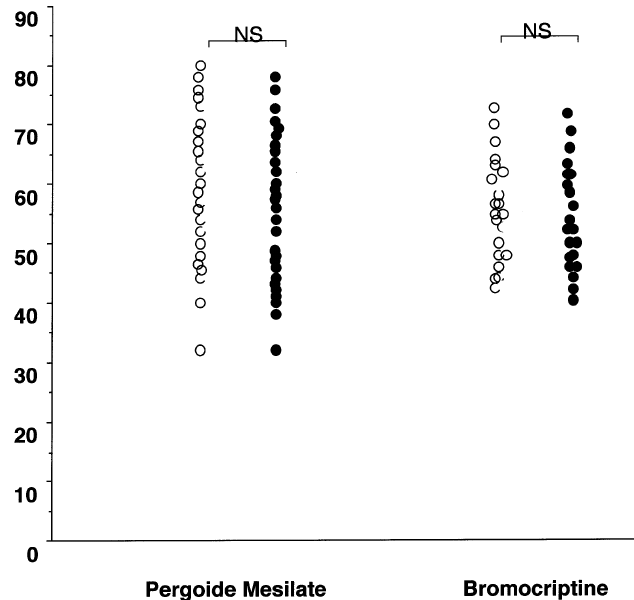
Fig. 3. Unified Parkinson’s Disease Rating Scale UPDRS motor score comparing scores comparing those at baseline ( (cid:3) ) and after taking pergolide mesilate (left) or bromocriptine ( • ) (right). After taking pergolide mesilate or bromocriptine, patients taking pergolide mesilate showed significant improvement in the UPDRS motor scores (from 29.6 ± 5.5 to 26.4 ± 6.6 and from 29.2 ± 3.3 to 23.1 ± 3.0, respectively, p < 0 . 05